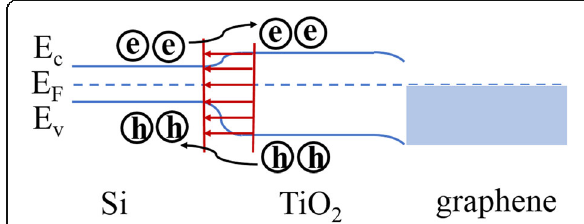
Fig. 4 Band scheme of the graphene/TiO 2 /Si